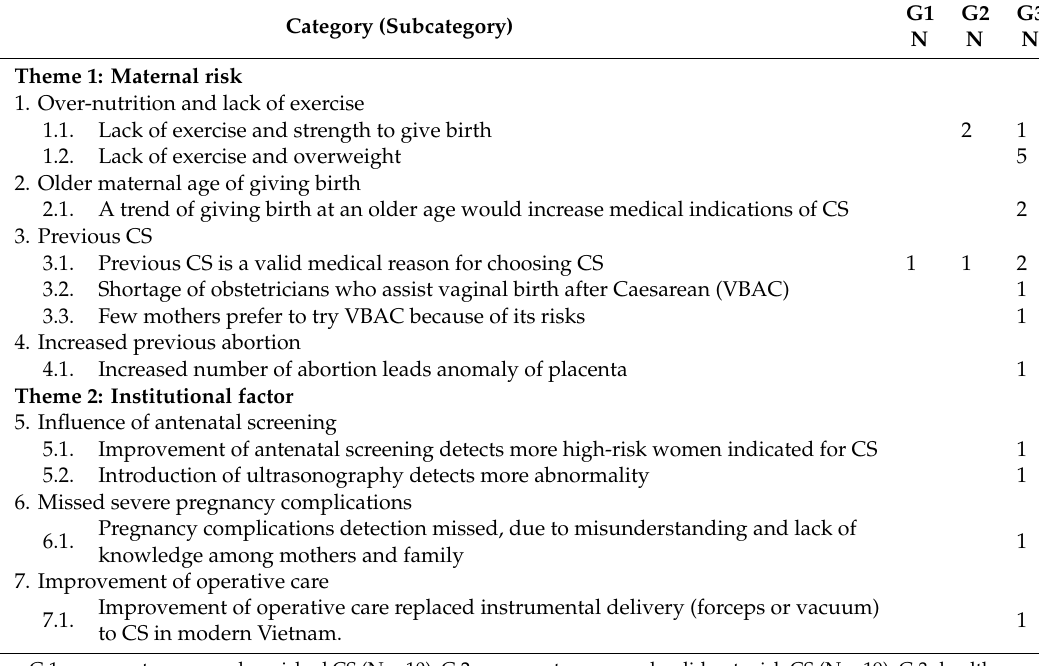
Table 3. Medical factor for